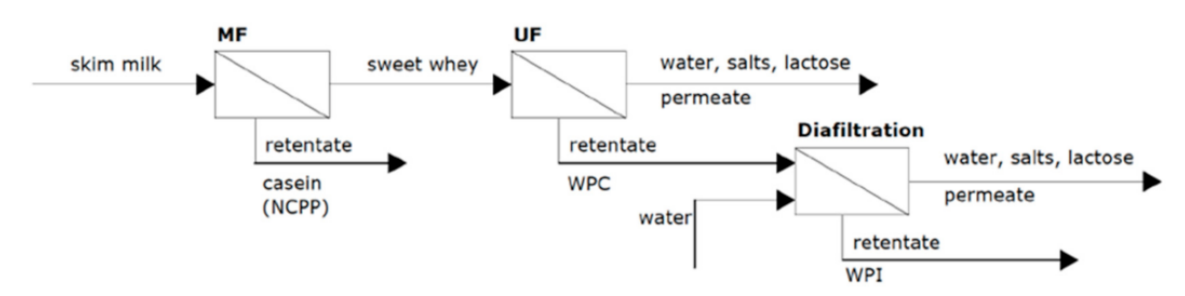
Figure 8. MF of skimmed milk to obtain NCPP and UF with diafiltration to obtain WPC and WPI from MF